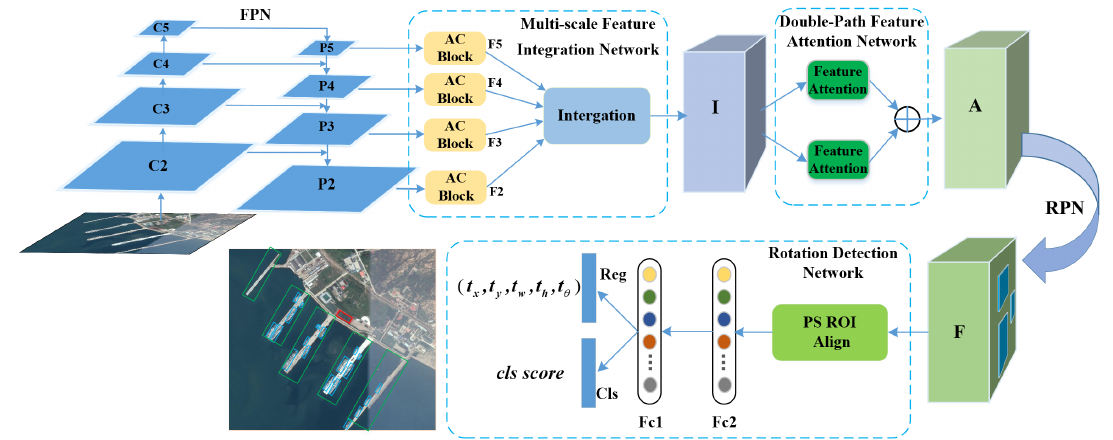
Figure 2. Overview framework of Multi-scale Feature Integration Attention Rotation Network (MFIAR-Net) for oriented object detection. The proposed framework based on FPN, consists of Multi-scale Feature Integration Network, Double-Path Feature Attention Network and Rotation Detection